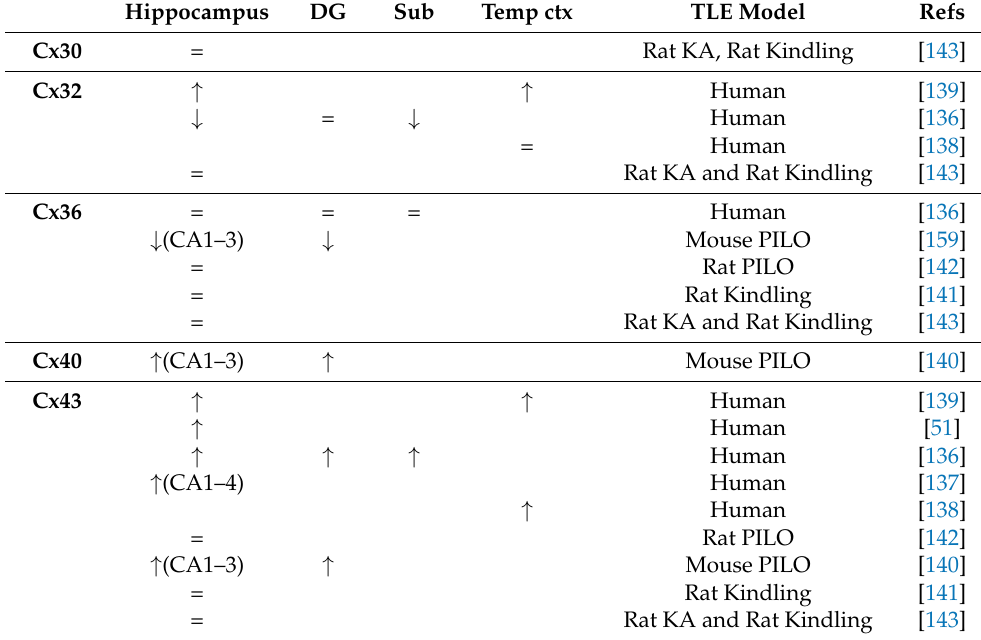
Table 5. Alterations of gap junction